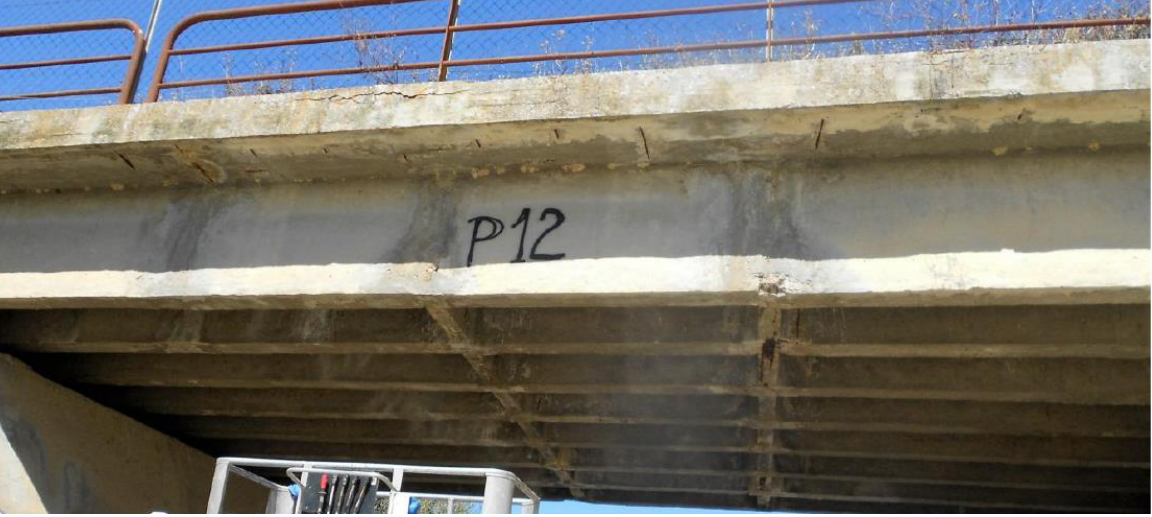
Figure 4: T3 type